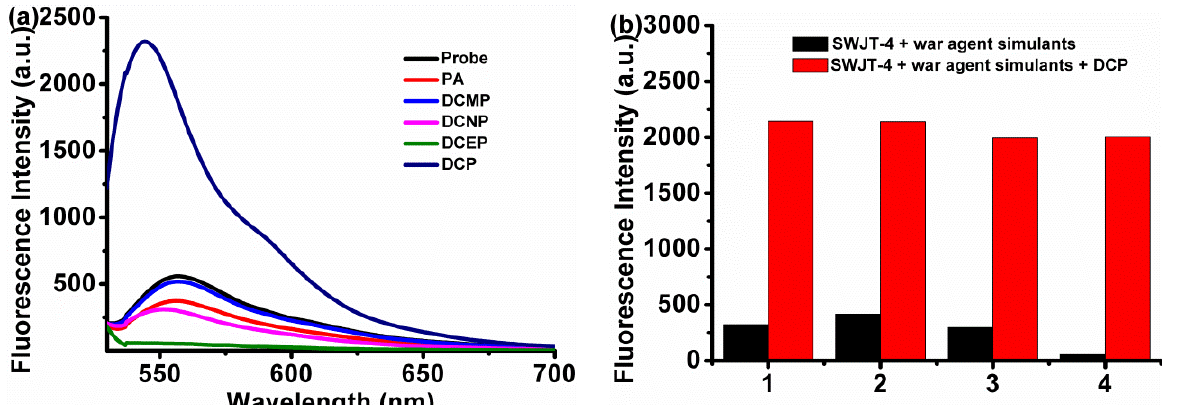
Figure 2. The fluorescence responses of ( a ) SWJT-4 (10.0 µM) with different war agent simulants (1.0 mM). From left to right: SWJT-4 , phosphoric acid (PA), cyanomethyl diethyl phosphate (DCMP), cyanoyl diethyl phosphate (DCNP), ethyl dichlorophosphate (DCEP) and diethyl chlorophosphate (DCP); ( b ) SWJT-4 (10.0 µM) with different war agent simulants (1.0 mM) and DCP (1.0 mM) in DMSO–HEPES (1/1, v/v , pH 7.4) buffer solution (1, phosphoric acid; 2, cyanomethyl diethyl phosphate; 3, cyanoyl diethyl phosphate; 4, ethyl dichlorophosphate). Black bar: SWJT-4 + war agent simulants; red bar: SWJT-4 + war agent simulants + DCP.